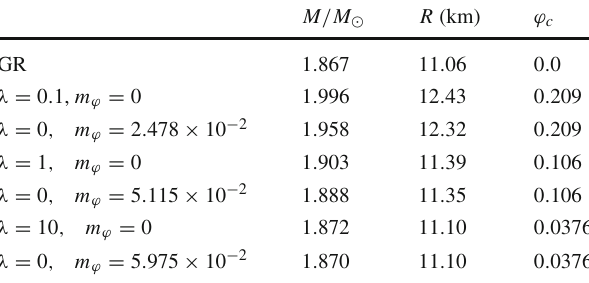
Fig. 3 (Top) The scalar field distribution with the radial coordinate for models with equal mass. The models are with β = − 6 and m ϕ = 10 − 3 anddifferentvaluesfor λ (blueindifferentpatterns).(bottom)Theradial distribution of the scalar field for models with equal central density. The resultsareformasslessSTTwithself-interaction(blue),andformassive STT without self-interaction (black) Table 1 Parameters of the star for GR, massive STT without self- interaction, and massless STT with self interaction for the same